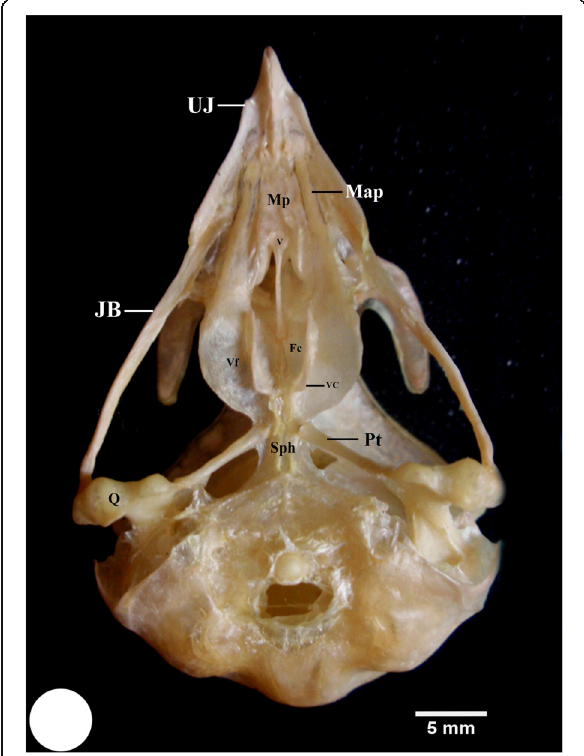
Fig. 4 Photomacrograph of ventral surface of skull of kestrel shows upper jaw (UJ), Jugal bar (JB), the maxillary process of the palatine bone (Map), maxillopalatine process (MP), vomer bone (V), choana fossa (Fc), medial crest (arrow), ventral crest (Vc), ventral fossa (Vf), Pterygoid (Pt), and parasphenoid